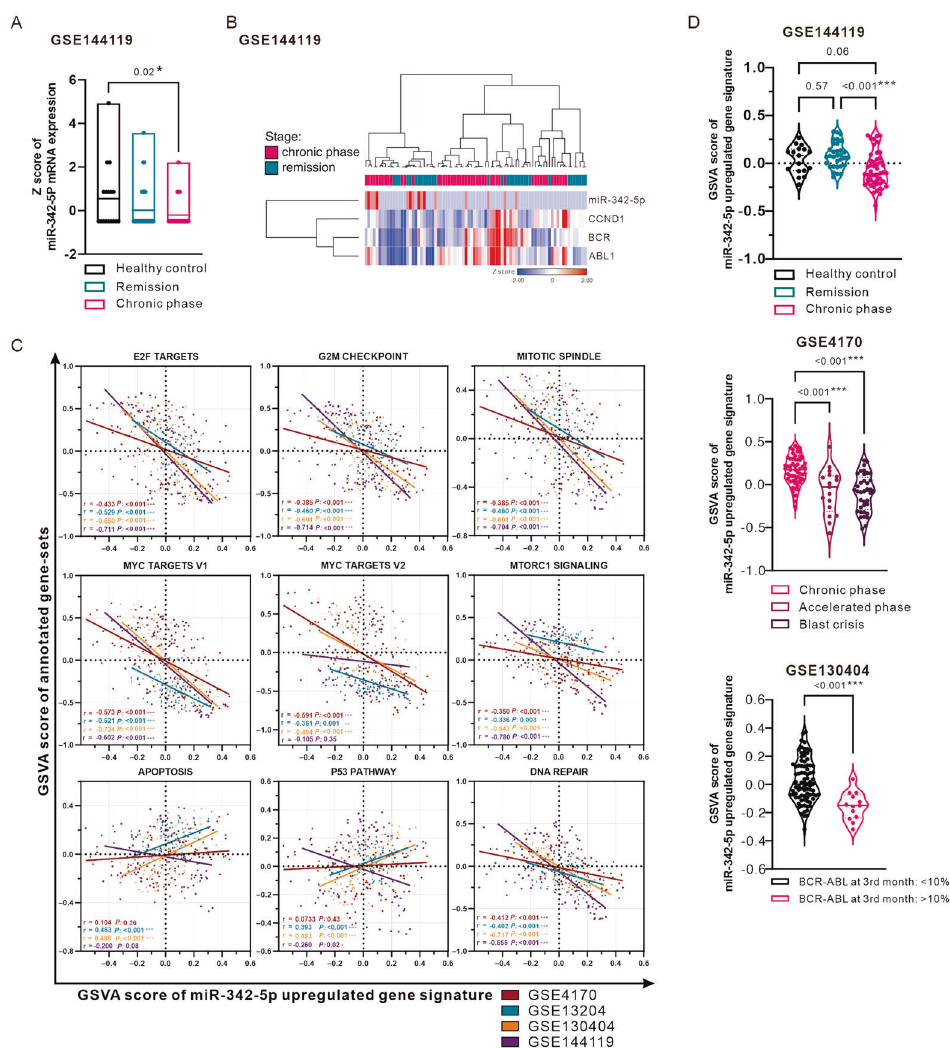
Fig. 7 Assessment of miR-342-5p upregulated-gene signature GSVA scoring in clinical CML databases correlates with cell proliferation, apoptosis and DNA repair-related pathways. A Box plot illustrating the distribution of normalized miR-342-5p (miR-4664) expression in patients ’ blood with different stages in GSE144119. B Heat map demonstrating expression of miR-342-5p, CCND1, BCR, and ABL1 in patients ’ blood with chronic phase or remission stage in GSE144119. C Correlation plot presenting the relationship between GSVA score of miR-342-5p upregulated-gene signature and Hallmark gene-sets associated with cell proliferation, apoptosis, and DNA repair. The correlation was evaluated using Pearson correlation in GSE4170, GSE13204, GSE130404, and GSE144119. ns: non-signi fi cant; * P < 0.05; ** P < 0.01; ** *P < 0.001. D Evaluation of miR-342-5P upregulated-gene signature GSVA scores in patients with different stages of disease (GSE144119, upper panel; GSE4170, middle panel) or different BCR-ABL expression (GSE130404, lower panel) in clinical CML